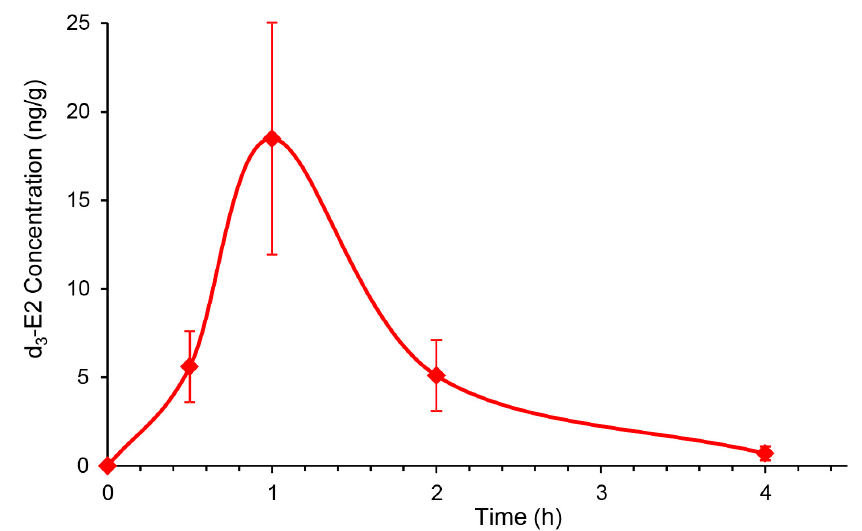
Figure 5. Exploratory survey of the concentration of d 3 -E2 in the female New Zealand white (NZW) rabbit retina after a single eye drop (40 µ L) of 0.1% w / v d 3 -DHED. Data are mean ± SD, n = 4.